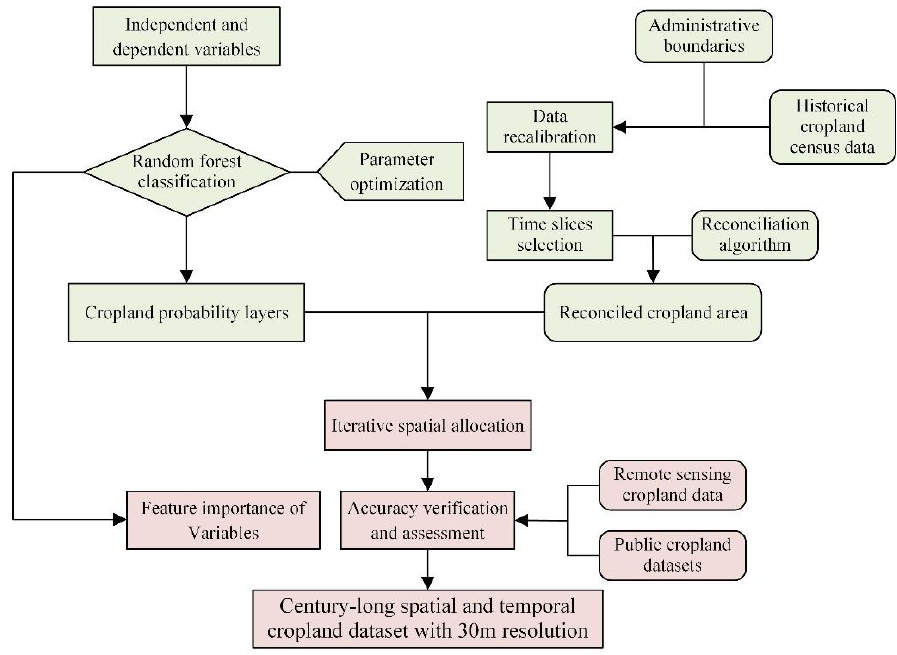
Figure 3. Flowchart for reconstruction and assessment of cropland maps.